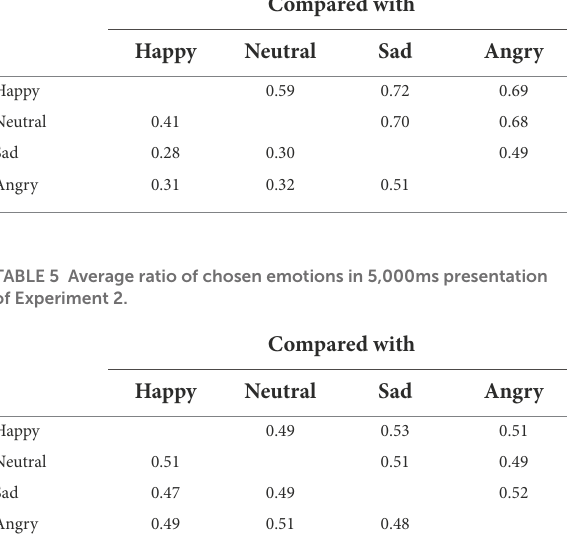
TABLE 4 Average ratio of chosen emotions in 500 ms presentation of Experiment 2.